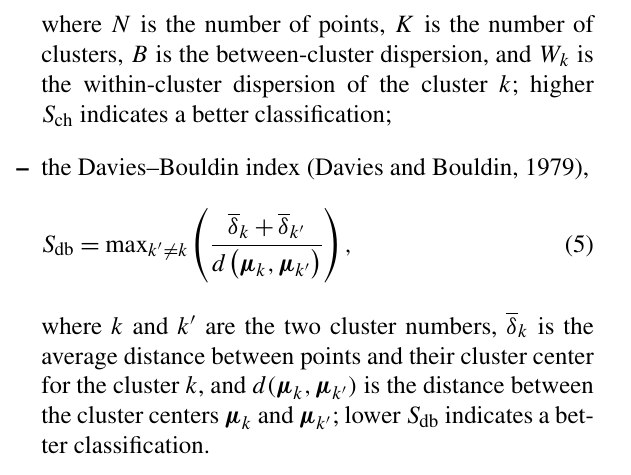
Figure 7. Relative influence of parameters on the different metrics. The x axis indicates the parameters of the code, and the y axis indi- cates the metrics. The shading represents the influence of the param- eter on the metric with darker shading indicating a larger influence. The abbreviations for the parameters are described in Table 2, and the abbreviations for the metrics are described in Table